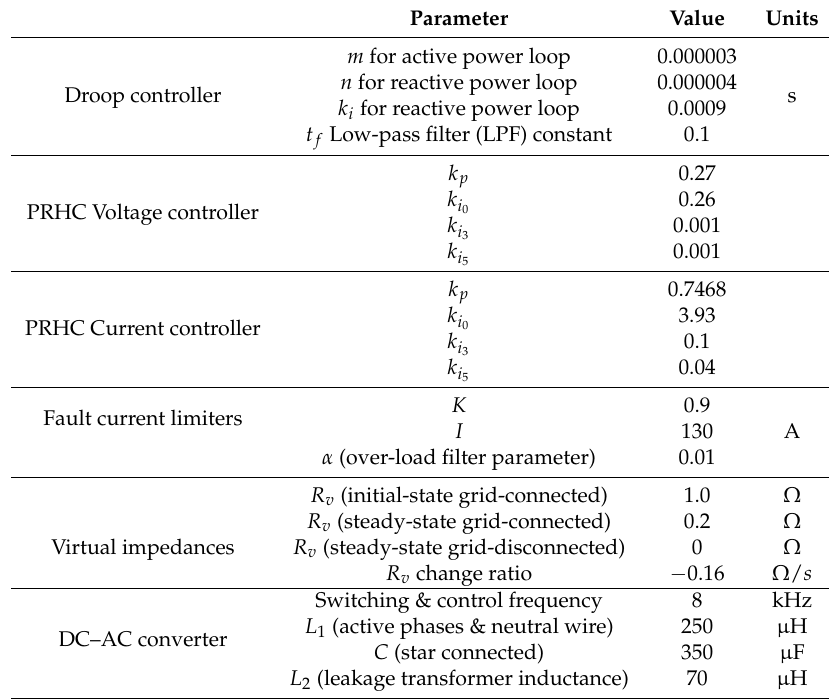
Table 2. Four-wire DC–AC (direct current–alternating current) converter parameters. PRHC (Proportional Resonant with Harmonic